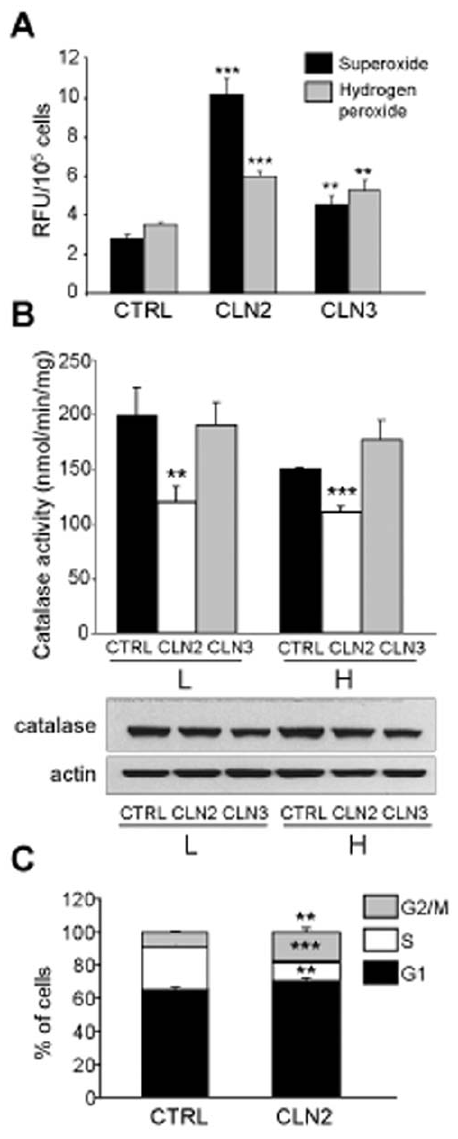
Figure 5. Alterations in oxidative stress in NCL fibroblasts. (A) Superoxide and hydrogen peroxide accumulation. Control, CLN2 and CLN3 fibroblasts incubated under high proteolysis conditions were stained with HE and DHR-123 and analyzed by flow cytometry as described in Materials and Methods. Results are shown as RFU values in 10 5 cells and represent the mean and S.D. from three separate experiments with triplicated samples. Representative dot blots are shown in Figure S3B. (B) Catalase activities and levels. Control (CTRL), CLN2 and CLN3 fibroblasts were incubated under low (L) and high (H) proteolysis conditions during 3 h. Catalase activity was measured as described in Materials and Methods (upper panel), and lysates (50 m g protein) were immunoblotted with catalase and actin antibodies (lower panels). Catalase activity values represent the mean and S.D. from three separate experiments. (C) Cell cycle analysis. Exponentially growing control (CTRL) and CLN2 fibroblasts, incubated in low proteolysis medium, were stained with PI and the distribution of cells in the different phases of the cell cycle was examined by flow cytometry as described in Materials and Methods. Results are shown as percentage of total cells and represent the mean and S.D. from three separate experiments. Representative dot blots and histograms are shown in Figure S3C. Stars indicate statistically significant differences from control values (**p , 0.01 and ***p , 0.005).